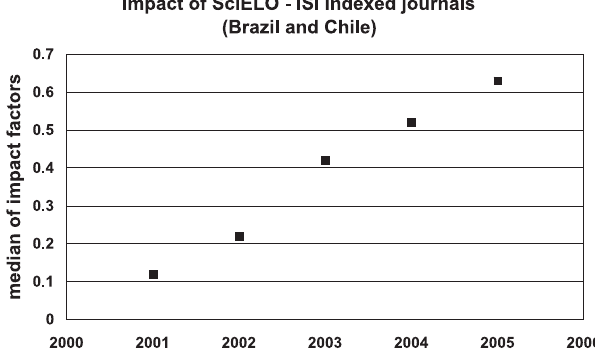
Figure 2 - Median impact of SciELO-ISI indexed Brazilian and Chilean journals (adapted from Meneghini, R, unpublished data)